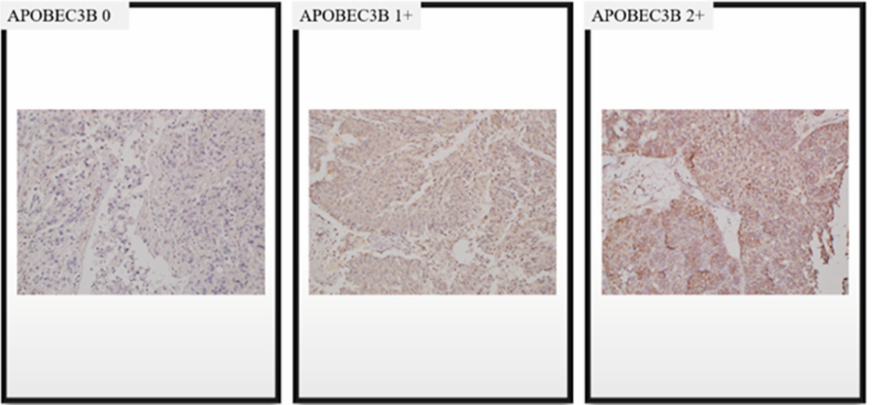
Figure 2. Immunohistochemistry staining of APOBEC3B.